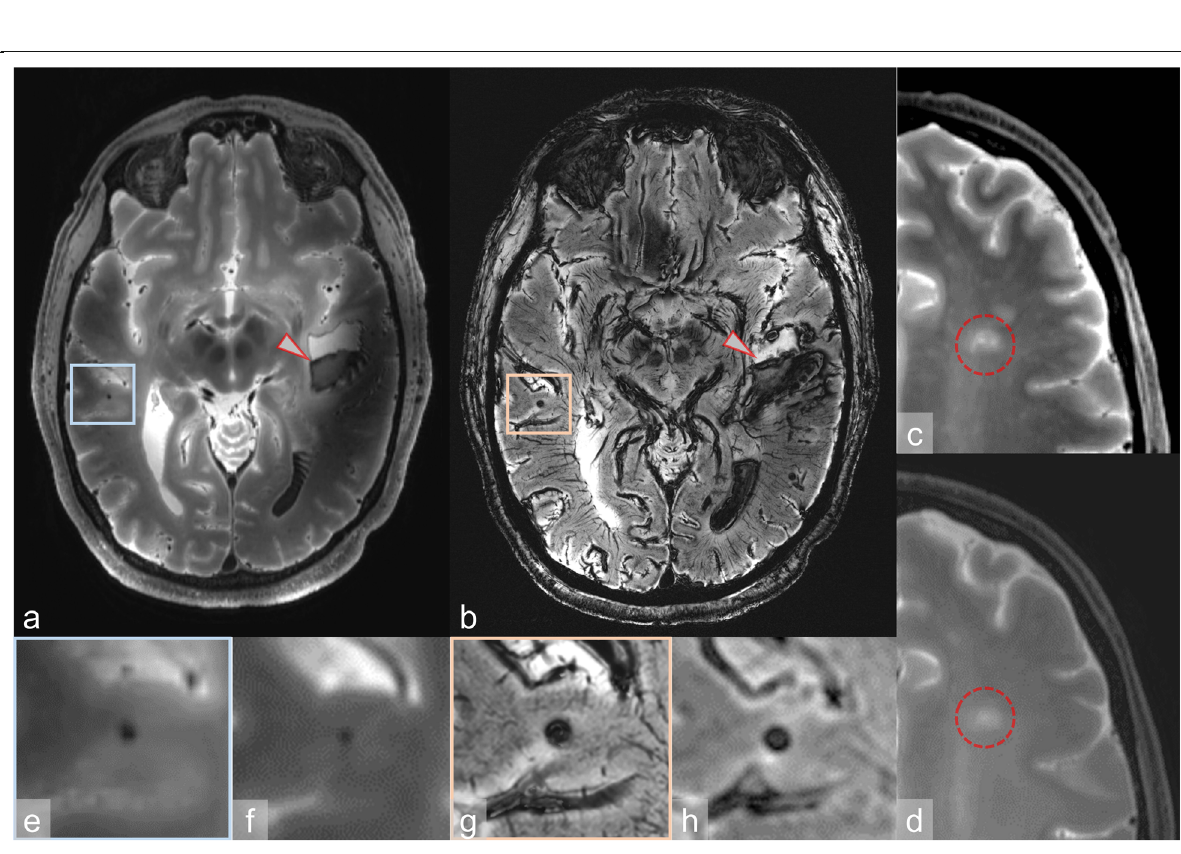
Fig. 3 a-h Case 2. An intraparenchymal haemorrhage was delineated on 7-T MRI (arrowhead in a : T2-weighted sequence (sampling perfection with application-optimised contrasts by using different flip angle evolutions, SPACE) and in b : susceptibility-weighted imaging). The haemorrhage presented with postmortem sedimentation. The SPACE image is limited by signal inhomogeneity visible on the anatomically left side adjacent to the haemorrhage. In addition, MRI detected subtle lesions, better delineated at 7 T than at 3 T: microinfarcts ( c : 7-T T2-weighted SPACE sequence; d : 3-T T2-weighted turbo field echo sequence), and microhaemorrhages ( e and g 7-T T2-weighted SPACE sequence and 7-T susceptibility- weighted imaging; f and h , 3-T T2-weighted turbo field echo sequence and venous blood oxygen level-dependent